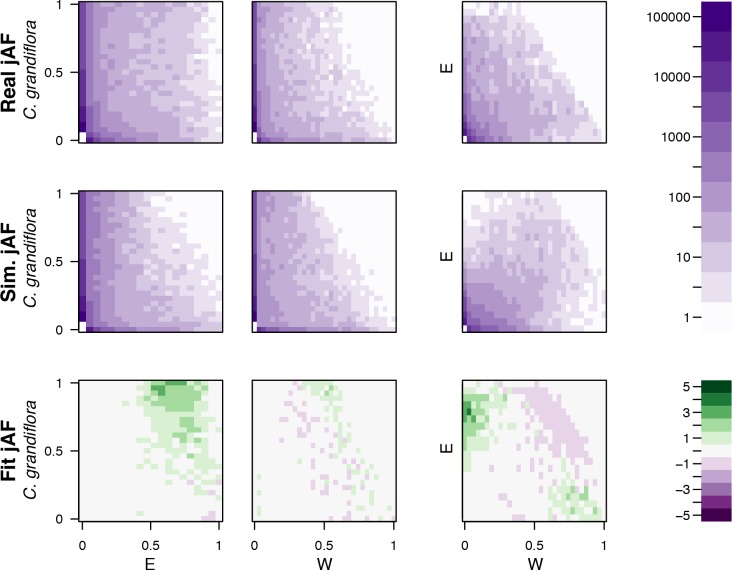
Comparison of simulated and observed allele frequency spectra under the best fitting demographic model.The fit of a simulated jMAF spectrum to the observed data using the most likely demographic model inferred by fastsimcoal2. Heatmaps in the top two rows show the number of mutations falling into a particular frequency class (the minor allele is assigned based on the allele frequency across both populations), while the bottom two rows indicate the residuals of the real data from the simulated (ndata-nmodel)/nmodel.